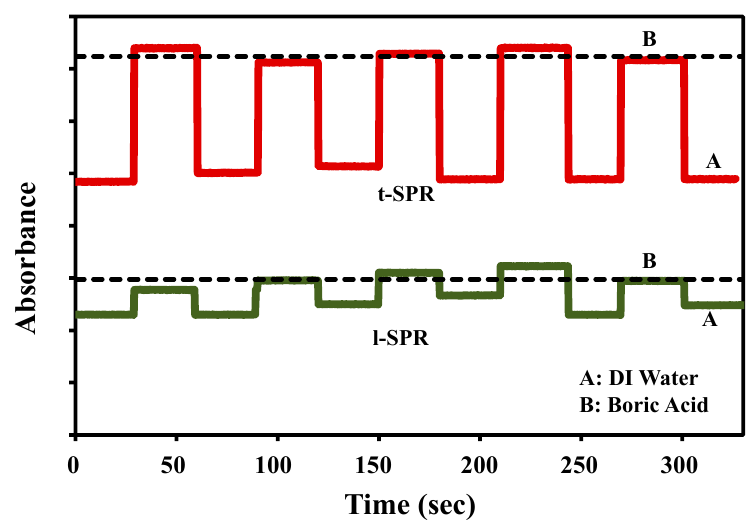
Figure 5. Plasmonic response of Au nanoplates towards boric acid and its corresponding response times with DI water as baseline. The dotted line represents the average peak intensity reading in the boric acid medium.